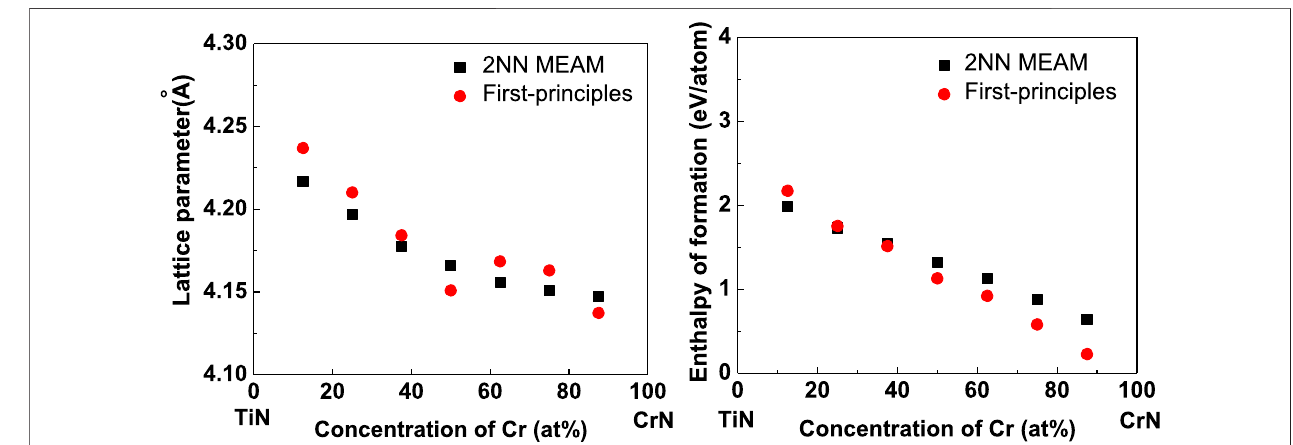
FIGURE 2 | Comparisons of the MEAM and fi rst-principles results for (A) the lattice parameter and (B) enthalpy of formation of FCC Ti x Cr 1-x N solid solution changing with the atom concentration.